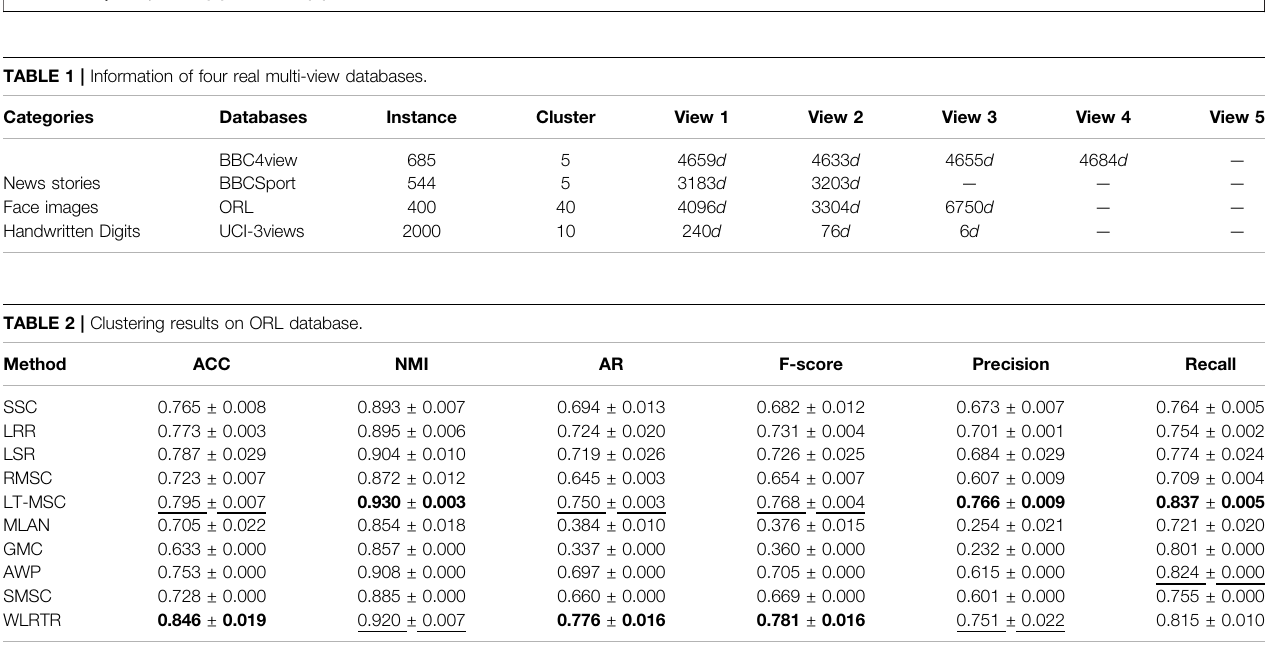
FIGURE 1 | Samples of (A) ORL and (B) UCI-3views databases.